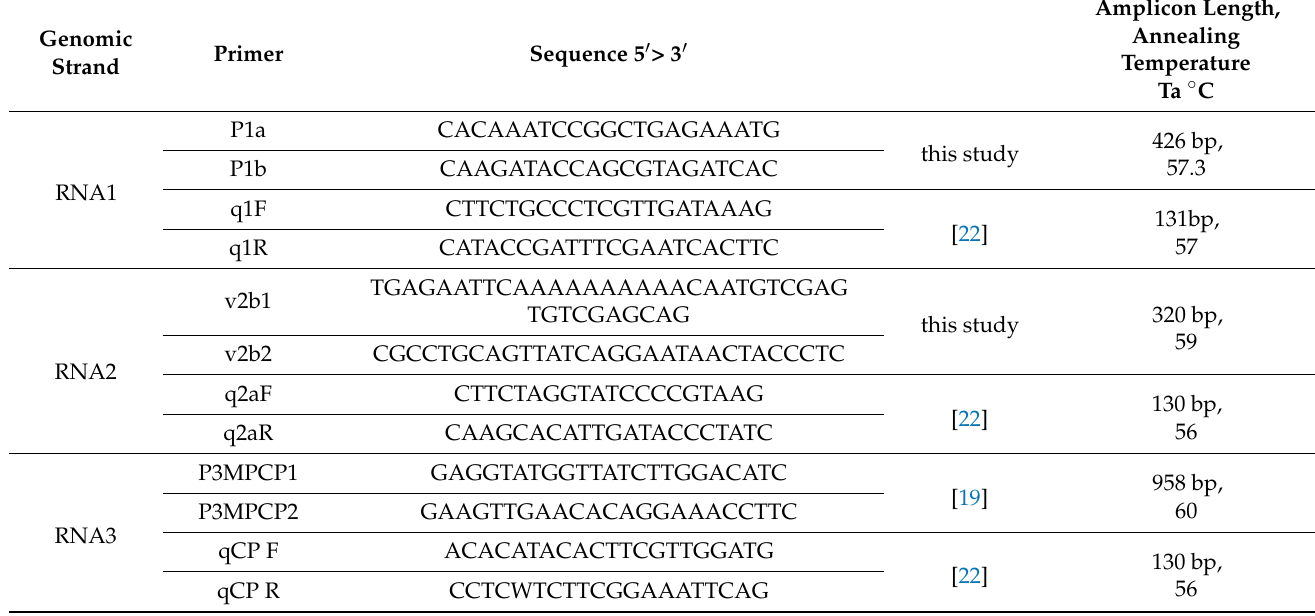
Table 1. The sequences of diagnostic primers hybridizing to peanut stunt virus